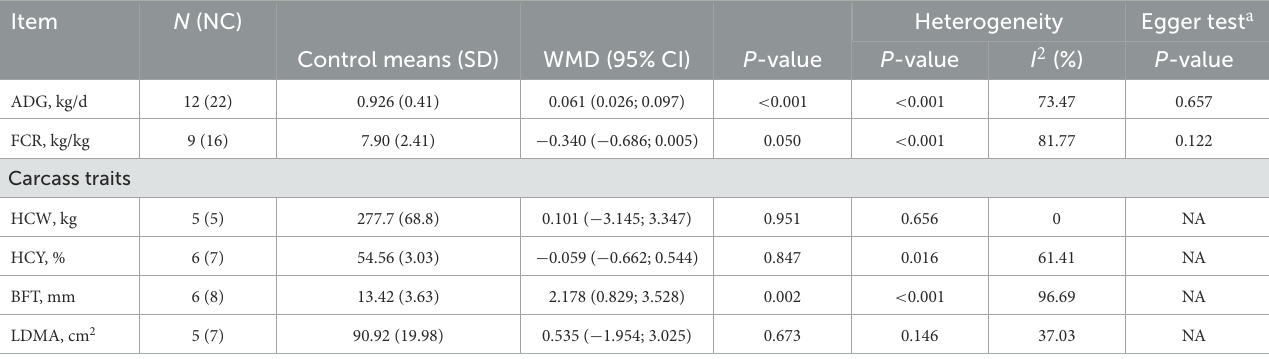
TABLE 2 Growth performance and carcass characteristics of cattle supplemented with